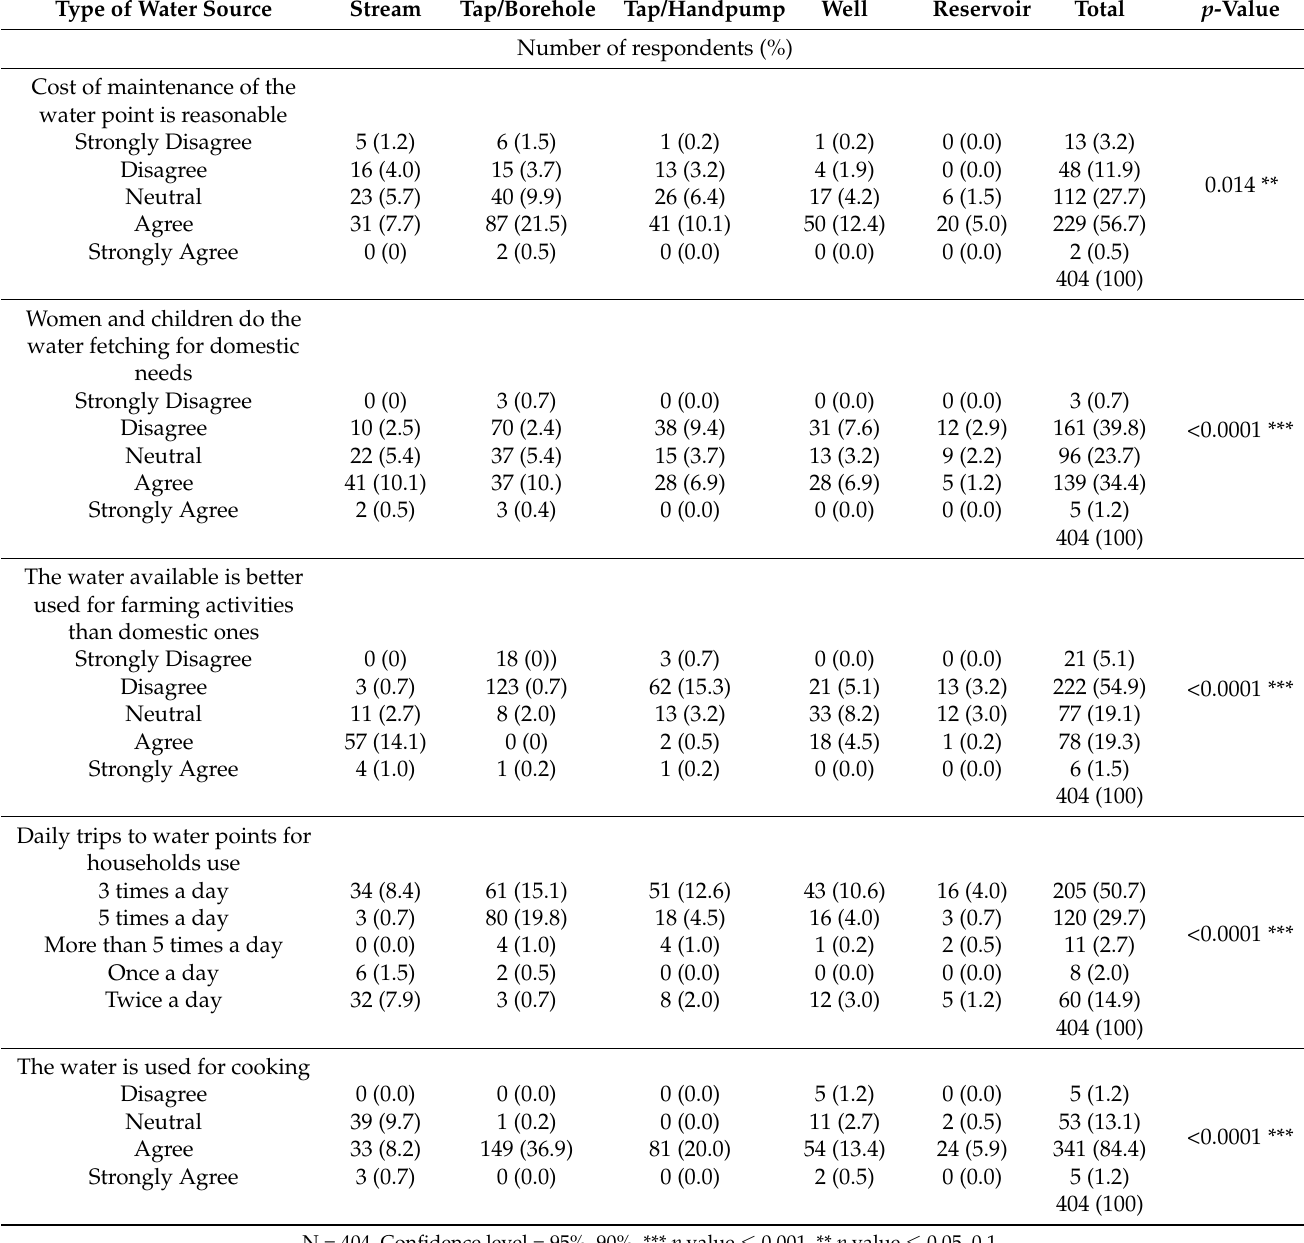
Table A1. Test of association of water practices with water